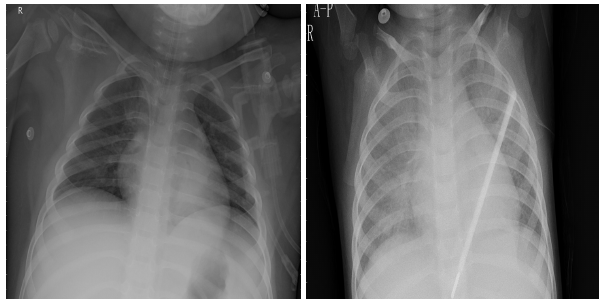
Figure 16. Example of different